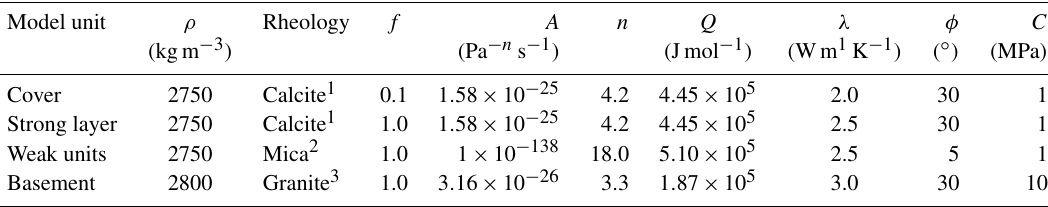
Table 1. Table listing the material properties of our model units for most models, where ρ is the density, A is the pre-exponential factor, f is custom prefactor, n is the stress exponent, Q is the activation energy, λ is the thermal conductivity, φ is the friction angle, and C is the cohesion. Some additional parameters are constant: the thermal expansion coefficient α = 3 × 10 − 5 K − 1 , the heat capacity C p = 1050JK − 1 and the radiogenic heat production Q r = 10 − 6 Wm − 3 . We use creep flow laws from Schmid et al. (1977), 1 Hansen and Carter (1983) 2 and Kronenberg et al. (1990).